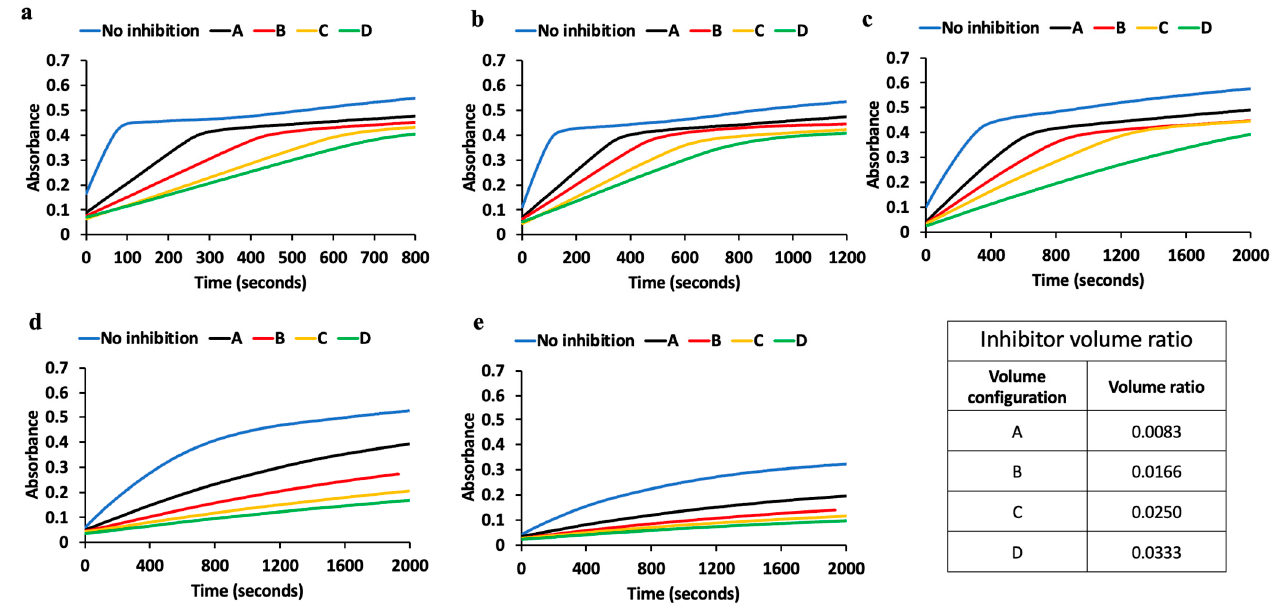
Figure 4. Enzyme kinetics measured using the 3D-printed spectrophotometer without inhibition and with different degrees of inhibition (controlled by the volume concentration of the inhibitor shown in the inset table). ( a ) Enzyme kinetics monitored at Rate1 being the fastest rate and at a different volume concentration of the inhibitor. ( b ) Enzyme kinetics monitored at Rate2 without inhibition and at a different volume concentration of the inhibitor. ( c ) Enzyme kinetics monitored at Rate3 without inhibition and at a different volume concentration of the inhibitor to inhibit the enzyme activity. ( d ) Enzyme kinetics monitored at Rate4 without inhibition and at a different volume concentration of the inhibitor to inhibit the enzyme activity. ( e ) Enzyme kinetics monitored at Rate5 being the slowest without inhibition and at a different volume concentration of the inhibitor to inhibit the enzyme activity. The table indicates different volume ratios of kojic acid used in the 3 mL reaction–mix solution.